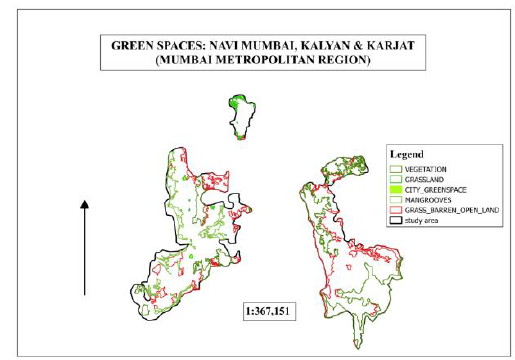
Figure 4 : The Green Spaces in Select Sub-regional Spaces The area covered with variety of vegetation has been digitised and converted into area vector. Using QGIS, the areas under the green spaces has been calculated. The ratio of total area and green area has been calculated to arrive at a green space index that is standardised to be in the scale of 0 to